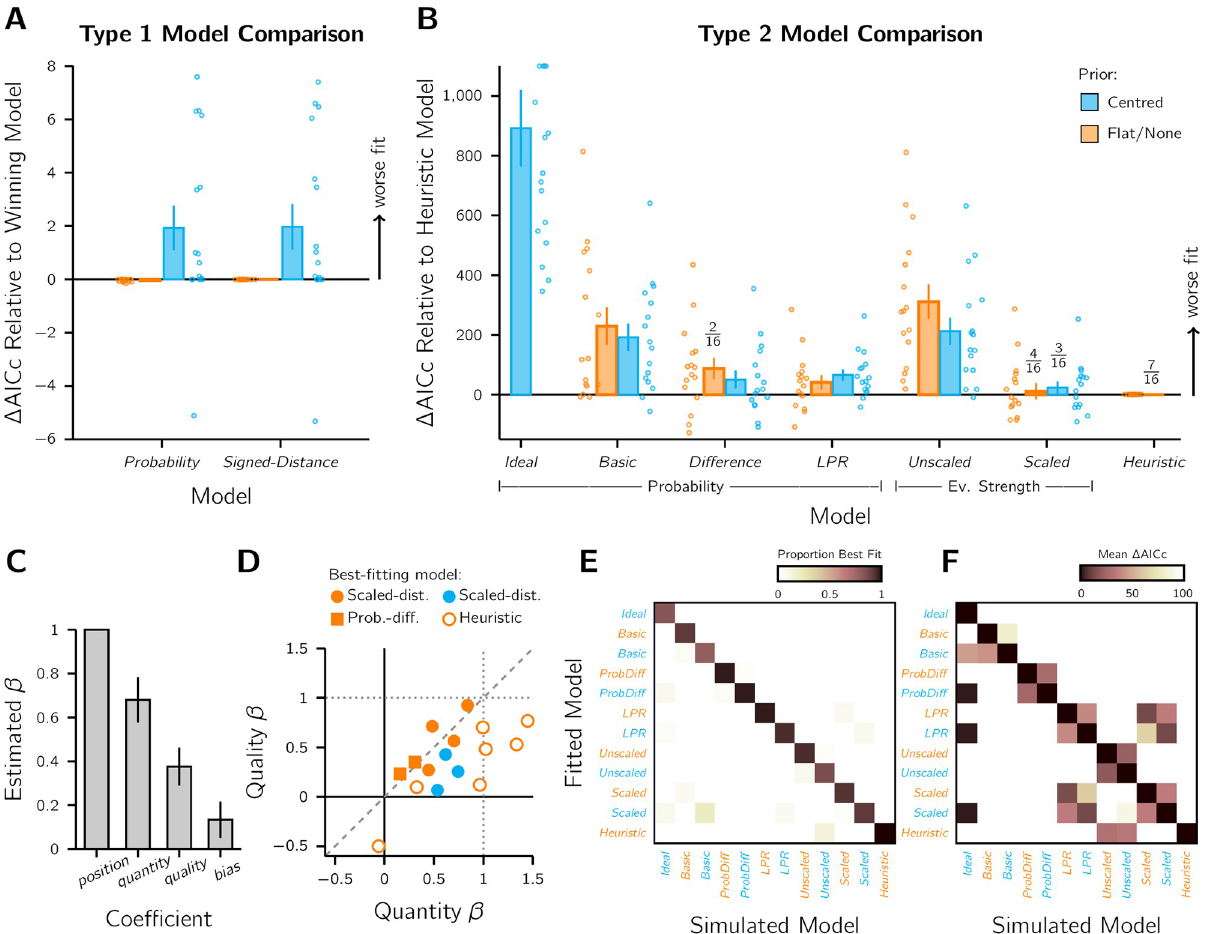
Fig 4. Model fit results ( n = 16). A) Relative AICc scores for the Type 1 models. Scores were compared to the winning flat-prior variant models. Bars: average relative AICc score. Markers: Individual participant results. Colour: flat-prior (orange) or centred-prior (blue) variant. Error bars: ± SEM. B) Relative AICc scores for the Type 2 models, with fraction best-fit annotated. Models are grouped by metric type. Note the different y-axis scales between panels A and B. C) Average best-fitting Heuristic-model coefficients across all observers. Note that the position coefficient was always fixed at 1 in the model, but is graphed to illustrate the relative coefficient weights. Error bars: ± SEM. D) The best-fitting quantity and quality coefficients per observer. Marker colour and type indicates the best-fitting model for that observer. Dotted lines: the position coefficient value for comparison. Dashed line: equality line. E) Model recovery results. For each model and observer, 10 data sets were simulated using the participant’s best-fitting parameters (1920 data sets total) and then fit by each of the 12 models. The best-fitting model was tallied per dataset per simulated model. Dark squares along the downward diagonal indicate high model recovery success. F) The relative AICc scores compared to the simulated model (downward diagonal of 0).